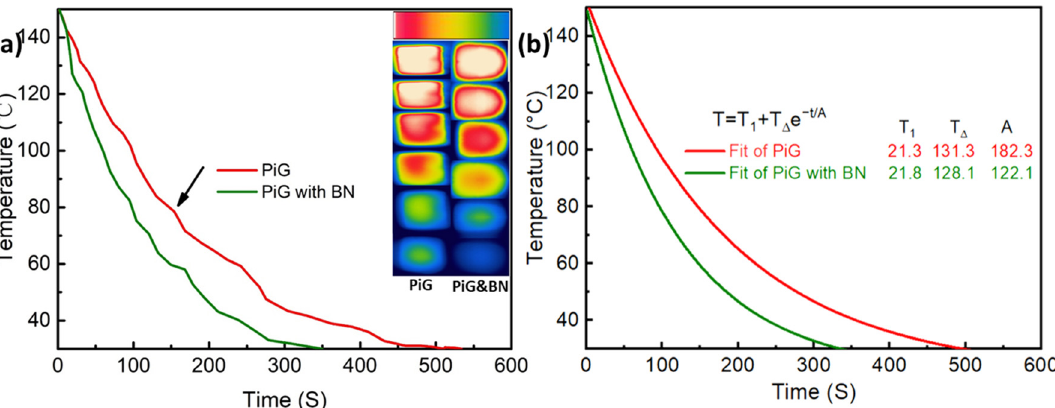
Figure 10. The cooling curves ( a ), fitted curves ( b ) and Infrared thermal images (insert in a) of PiG and PiG with BN.